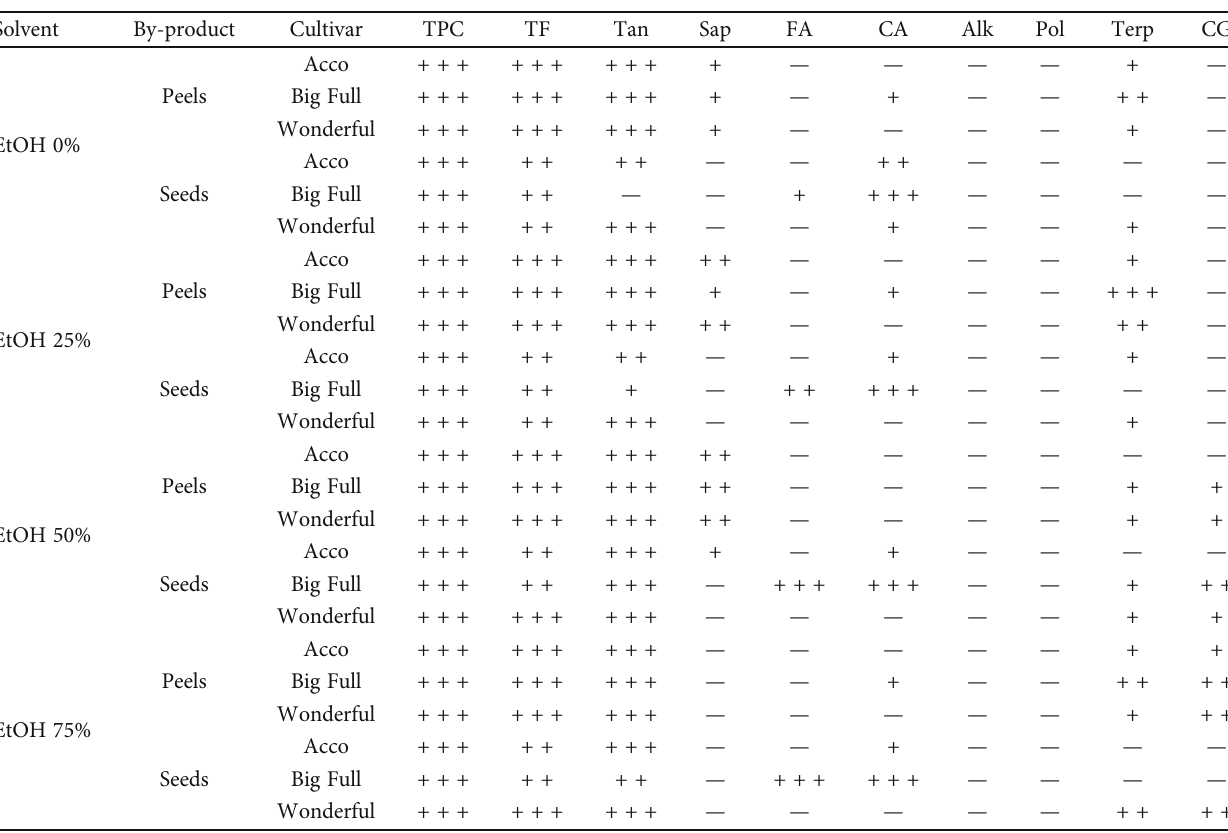
Results are expressed as meanvalues ± standarddeviation of duplicates of two assays. Table 2: Qualitative phytochemical screening of pomegranate peel and seed extracts according to the solvent used for extraction and the pomegranate cultivar.